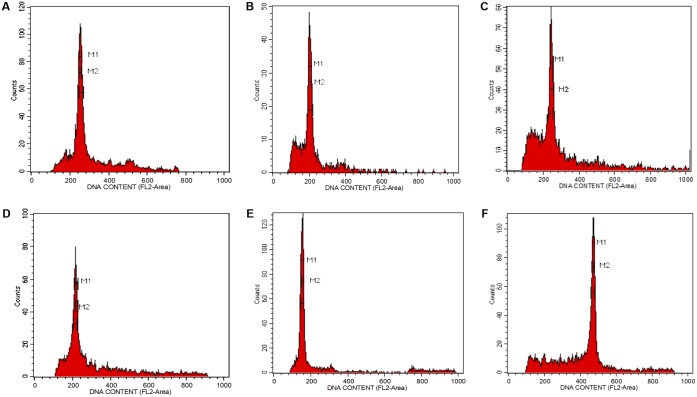
Fluorescence intensity histogram peaks showing the number of nuclei per channel as a function of relative fluorescence obtained after flow cytometric analysis of propidium iodide-stained nuclei. (A)
Aquilaria hirta, (B)
Aquilaria malaccensis, (C)
Aquilaria microcarpa, (D)
Aquilaria sinensis, (E)
Aquilaria subintegra, and (F)
Elaeis guineensis, which acted as an external reference standard.